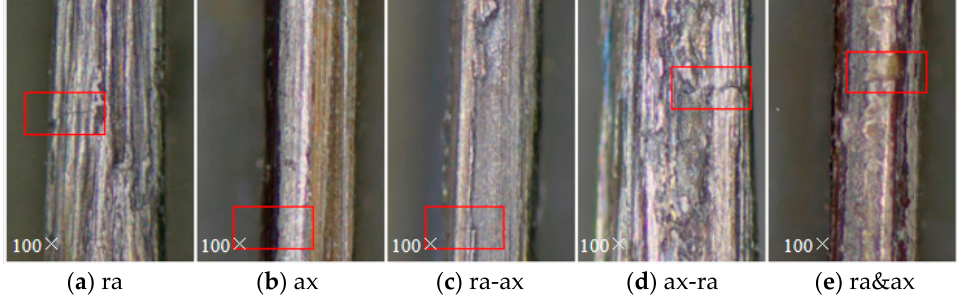
Figure 11. Cracks on the fin tip.